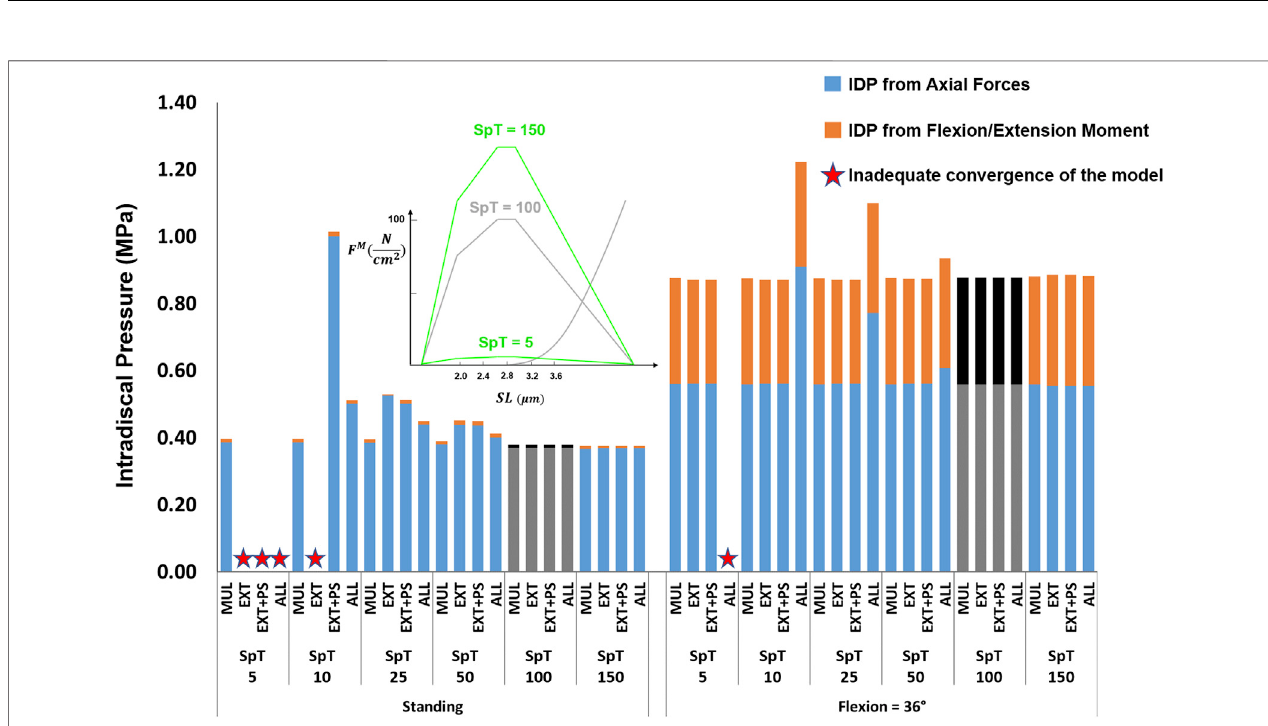
FIGURE 10 | The effect of different speci fi c tension (SpT) values on L4-L5 IDP in upright standing and 36 ° fl exion for four scenarios: changes applied to multi fi dus (MUL), extensor muscles (EXT), extensor muscles and psoas (EXT + PS), and all 210 muscles in the model (ALL). Grey bars represent the baseline values.